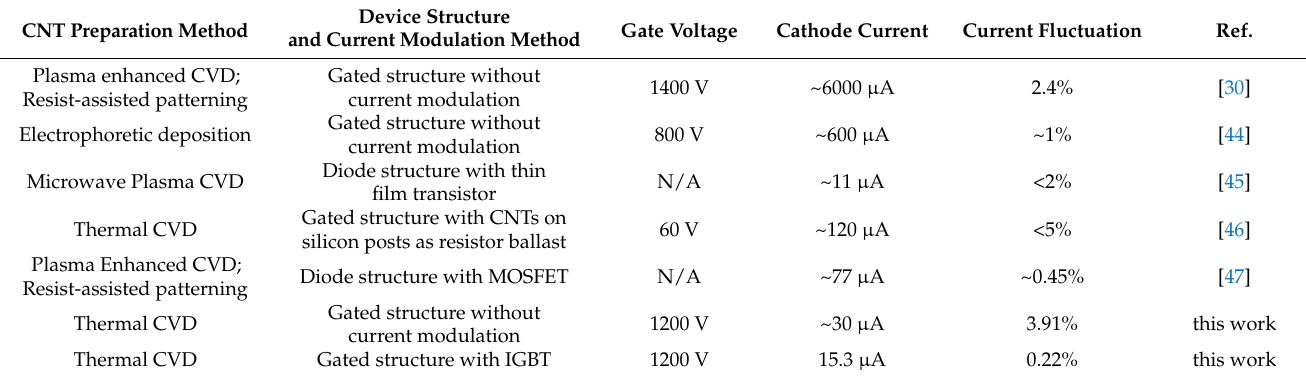
Table 1. The current stability of CNT electron sources reported in references.